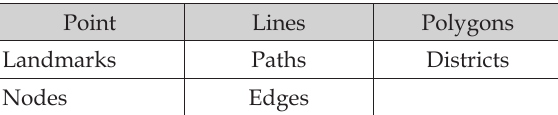
Table 1. Lynch element shapes Point Lines Polygons Landmarks Paths Districts Nodes